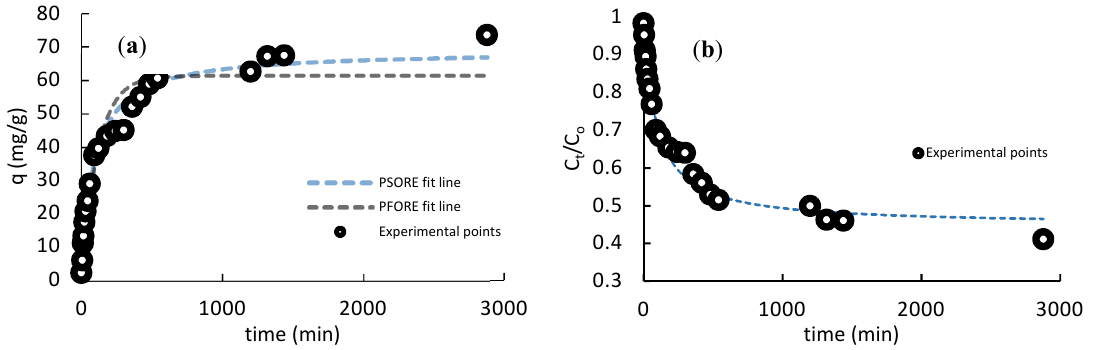
Figure 5. Kinetics isotherms. (T = 20 °C; pH 6, dose: 1 g/L, contact time: 48 h, agitation rate: 150 rpm)